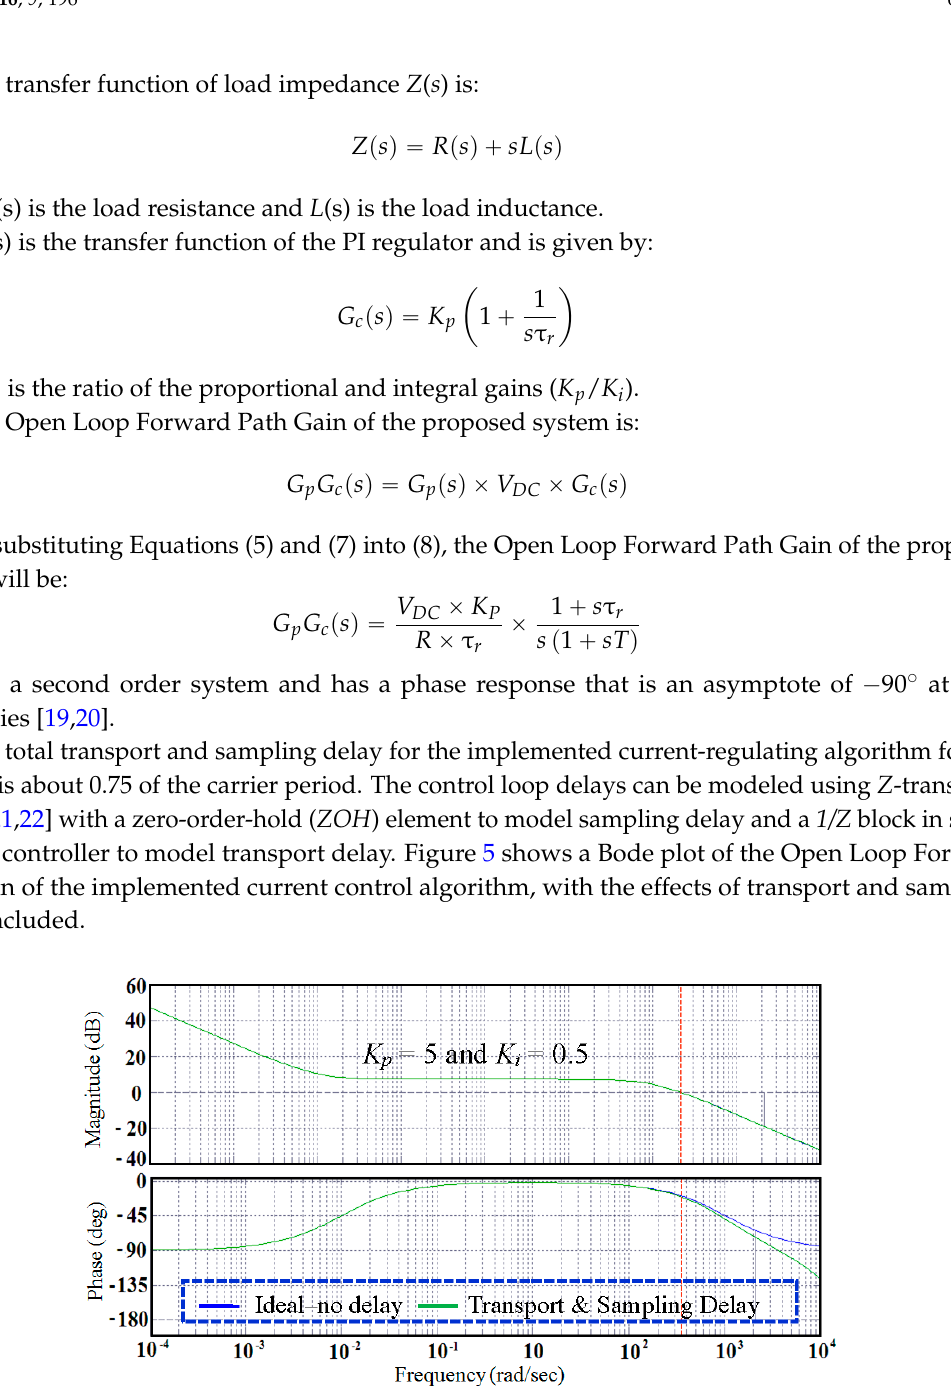
Figure 5. Bode plot of Open Loop Forward Path Gain for implemented controller with effects of transport and sampling delays.